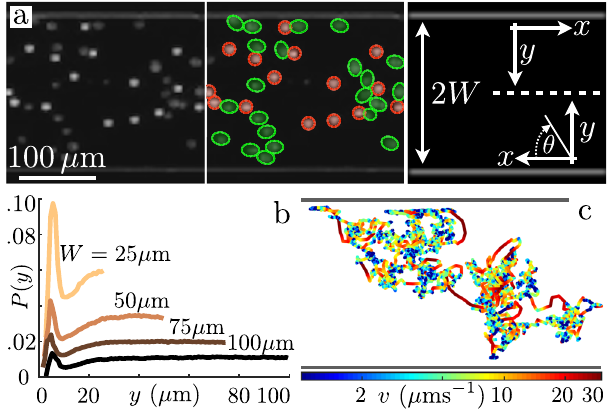
Fig. 1 | Experimental setup and colloidal behaviour. a Dark- fi eld image of cells and beads within a straight micro fl uidic channel (here width 2 W =200 μ m). The two species are highlighted with, respectively, green ellipses and red circles. The schematic illustrates the coordinate system used throughout. b Steady-state col- loidal probability distribution functions across the channel (edge to midpoint) for different W values. Boundary accumulation is followed by a depleted adjacent regionwhichgiveswaytoauniformdistributionwithinthechannel. c Exampleofa typical colloidal trajectory inside a 100 μ m-width channel. Colours represent the mean frame-to-frame speed. The dynamics is composed of slow diffusive-like motion (blue sections) interspersed with fast straighter jumps (red